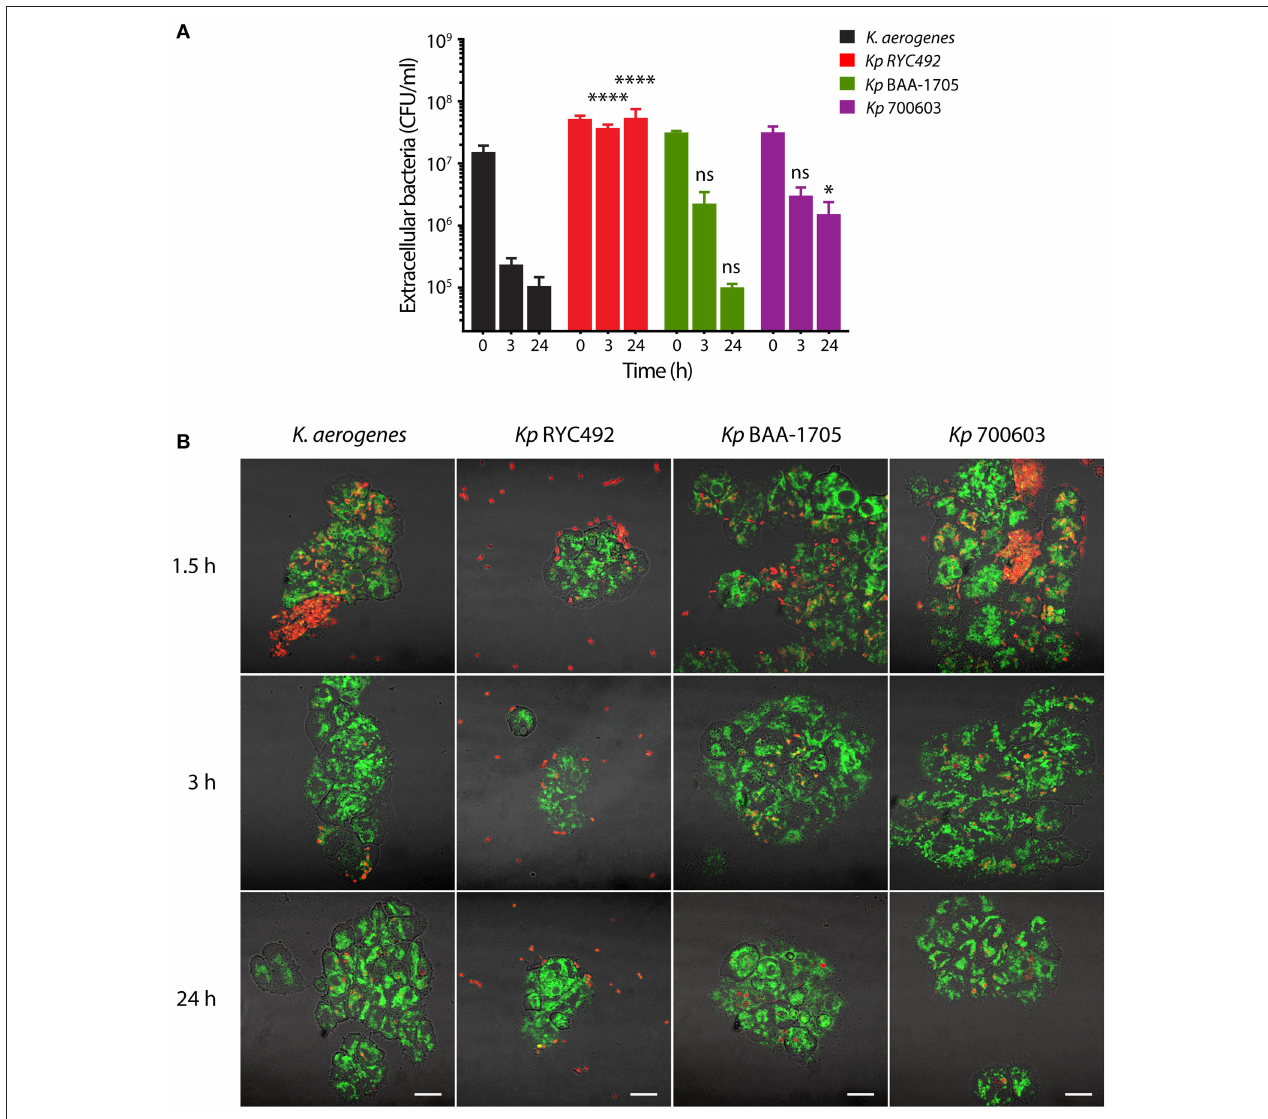
FIGURE 3 | Evaluation of the resistance to phagocytosis of K. pneumoniae using D. discoideum as host cell model. (A) Extracellular viable bacteria count after different times of Klebsiella -amoeba co-incubation. At each indicated time, the mixed cultures were centrifuged at low rpm in order to sediment D. discoideum cells and intracellular bacteria, and the CFU remaining in the supernatant were titrated. The symbols represent the mean of three independent experiments and the error bars correspond to the standard deviation. At times 3 and 24h, Kp RYC492 and Kp 700603 showed a significantly higher number of extracellular bacteria, compared with K. aerogenes (Two-way ANOVA, * p < 0.05, **** p < 0.0001). (B) Confocal microscopy images representative of the experiment showed in (A) . At each indicated time, an aliquot of the mixed cultures was directly mounted for microscopic observation (without centrifuging). D. discoideum cells are green and bacterial cells are red. Bright field and fluorescence images were blended in order to better appreciate the boundaries of the amoeba cells. Scale bar, 10 µ m.